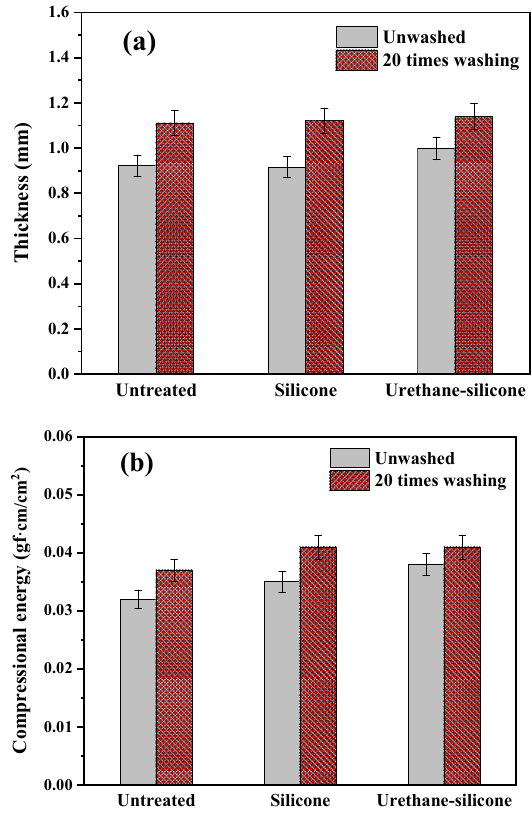
Figure 11. Compression properties of the cotton knit fabric untreated and treated with softeners. ( a ) Thickness; ( b ) compressional energy.